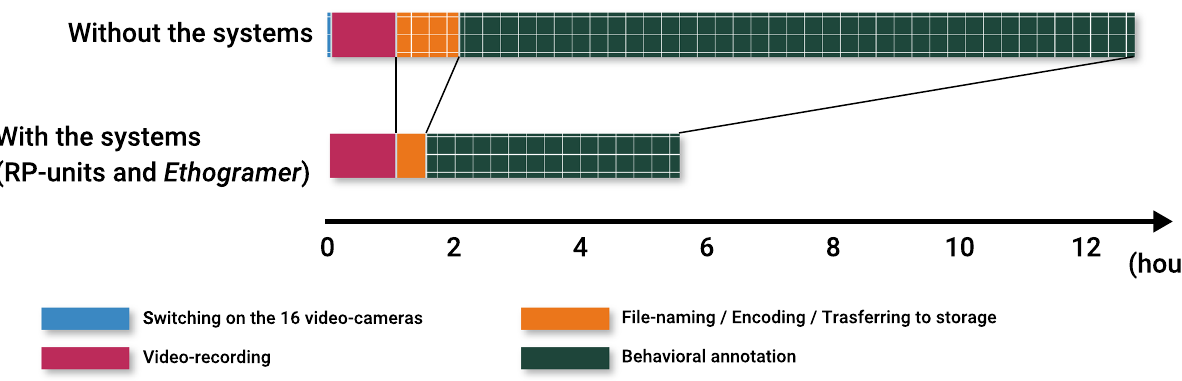
Figure 5. Conceptual diagram of the experimental procedures and their estimated time required for the behavioral analysis with or without the systems. By using the combination of the two systems established in this study, video-recording and their organization were completely automated, and behavioral annotation was drastically shortened and became easier compared to conventional manual behavioral annotation. Without the systems, the observer is forced to manually switch on 16 video cameras. Also, it is necessary to manually perform file-naming/encoding/transferring to strage, which takes approximately 1 h. Furthermore, the behavioral annotation without the Ethogramer took 40 min per video. Accordingly, it is expected that behavioral annotation for 16 pairs takes approximately more than ten hours. On the other hand, with the systems, video- recording of 16 pairs of medaka was automatically/simultaneously performed by running Record.sh via SSH remote login. Immediately after recording, file-naming, encoding, and transferring to storage were automatically performed, and it took approximately 30 min. Since the behavioral annotation was performed while replaying the first 30 min of each video at double speed by using Ethogramer , the time spent for the behavioral annotation of 16 pairs of medaka was only 4